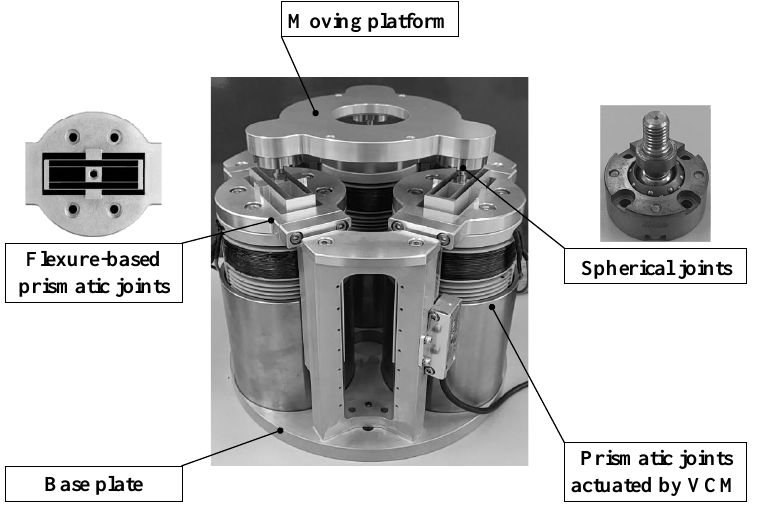
Figure 1. The prototype of the 2R1T 3PPS PKM as a force-controlled